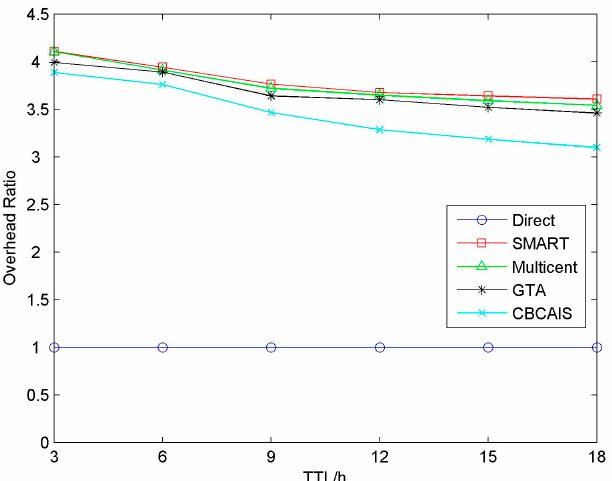
Figure 15. Overhead ratio for varying TTL.